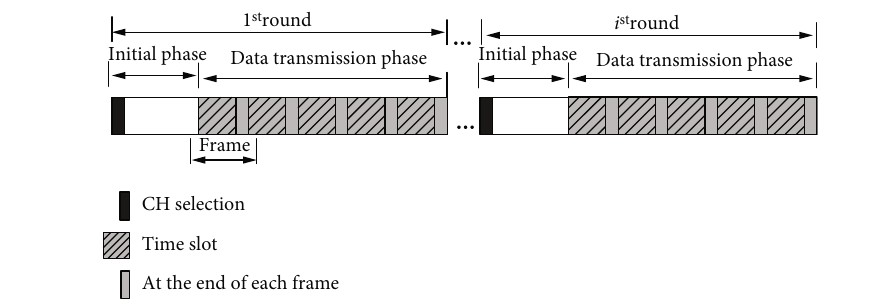
Figure 2: Round structure.